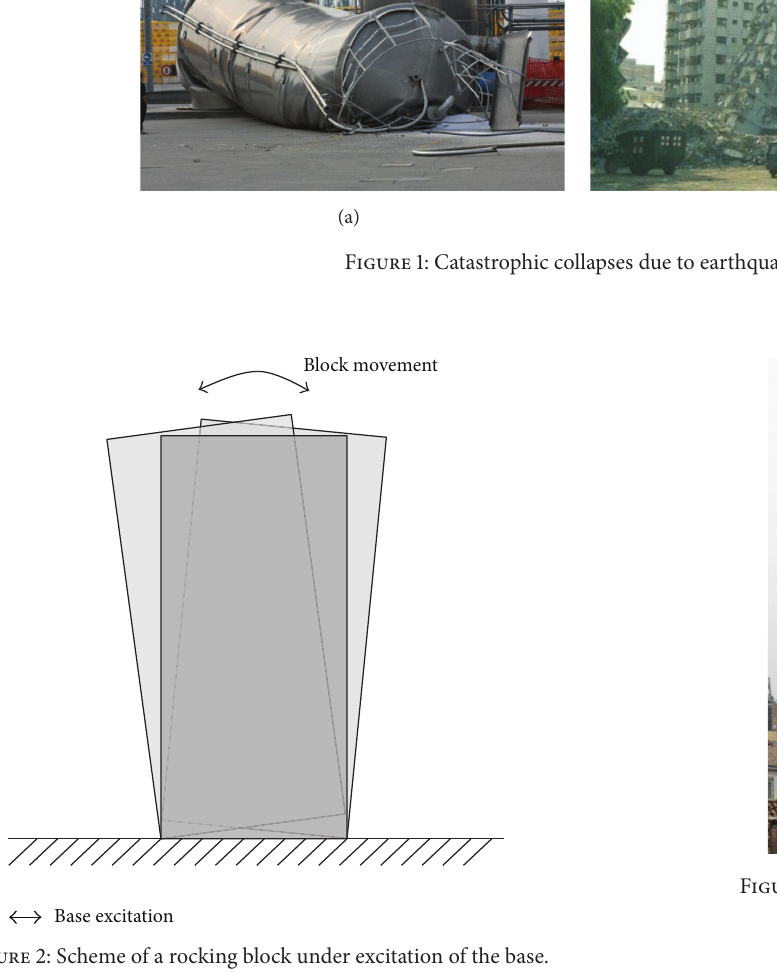
Figure 2: Scheme of a rocking block under excitation of the base.